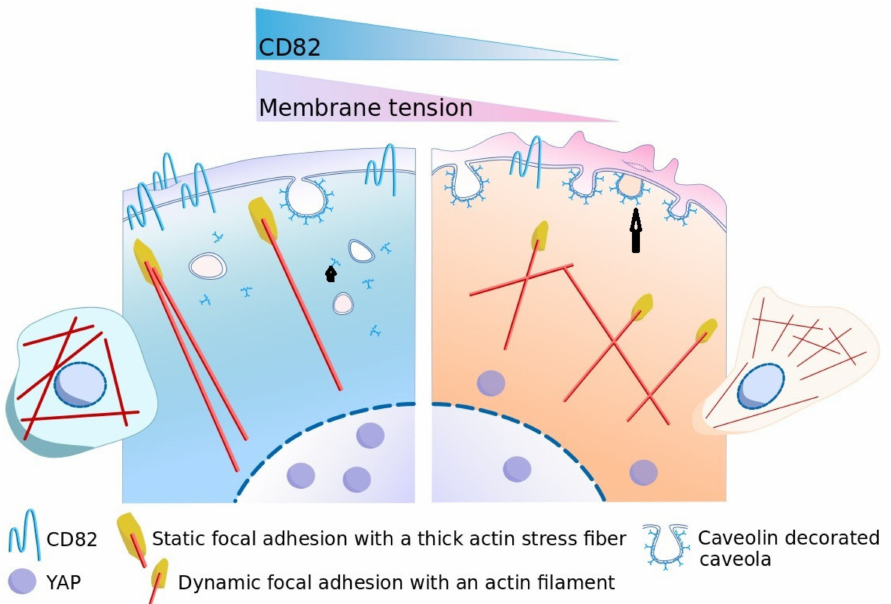
Figure 6. Model of CD82 action on 2D cell migration of epithelial cells. Left: In normal situations, CD82 is expressed and membrane tension is high; there are a few caveolae at the cell surface due to membrane tension buffering [18] and free caveolin-1 (black arrowhead). Free caveolin-1 can initiate a mechanotransduction cascade that drives YAP into the nucleus [21]. In turn, YAP controls caveolin-1 expression [26] and both YAP and caveolin-1 control focal adhesions [21,23] and actin polymerization [21,22] which also control membrane tension [16] and caveolae formation, looping a loop that keeps cells immobile. Right: When CD82 is poorly expressed, such as in breast carcinoma, the early loss of CD82 leads to a decrease in membrane tension, and an increase in cell surface caveolae (black arrow), allowing membrane tension fluctuations that, in synergy with actin polymerization fluctuations underneath the membrane [15] and with focal adhesion positioning at the leading edge [17], can form a stable lamellipodia required for persistent cell